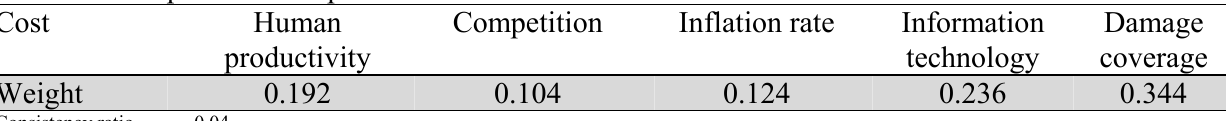
The results of pairwise comparison and AHP method in terms of five criteria